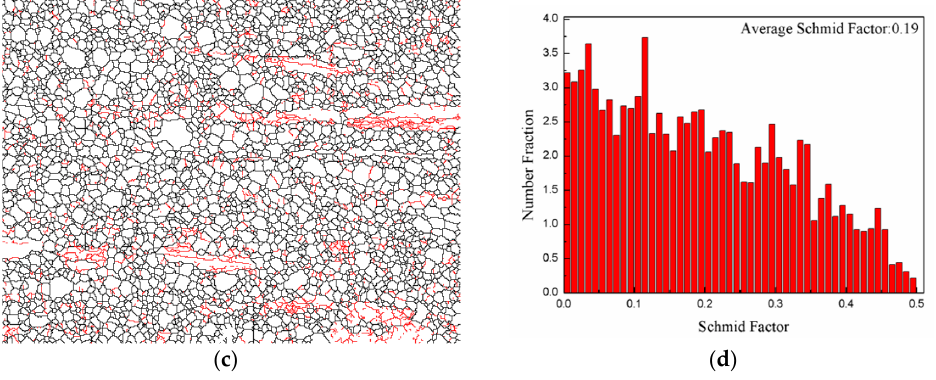
Figure 3. ( a ) EBSD (Electron Backscattered Diffraction) orientation maps and pole figures of the extruded alloy with and ( b ) without elongated grains, ( c ) misorientation angle distribution, ( d ) Schmid factor distribution map.